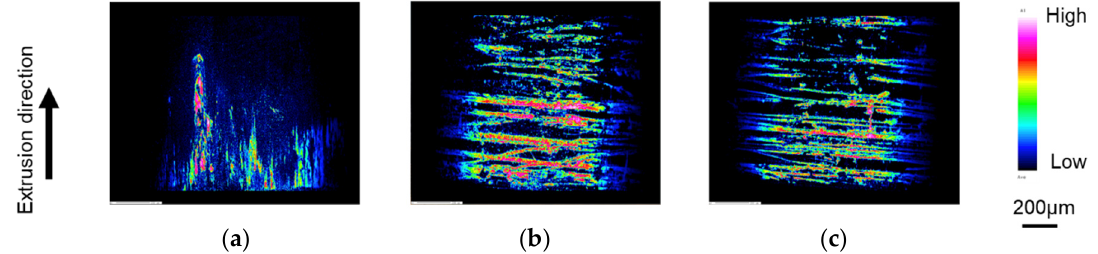
Figure 6. Evaluation of adhesion to punch by EPMA: ( a ) mirror surface punch; ( b ) grooved punch (depth 10 µm); and ( c ) grooved punch (depth 5 µm).